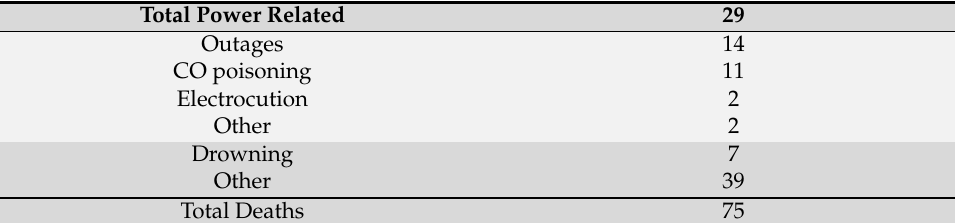
Table 1. Human casualties in Hurricane Irma